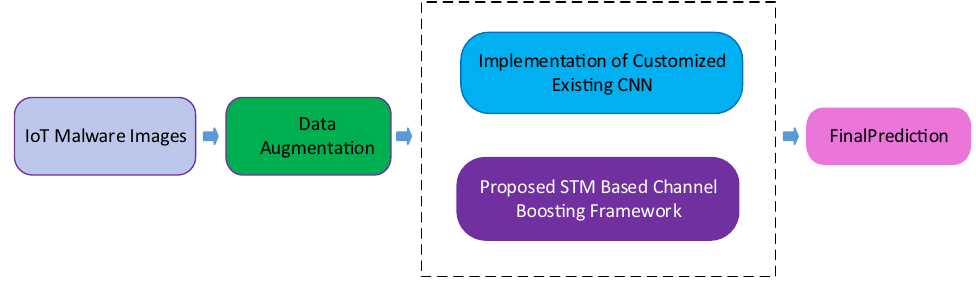
Figure 2. A brief overview of the proposed